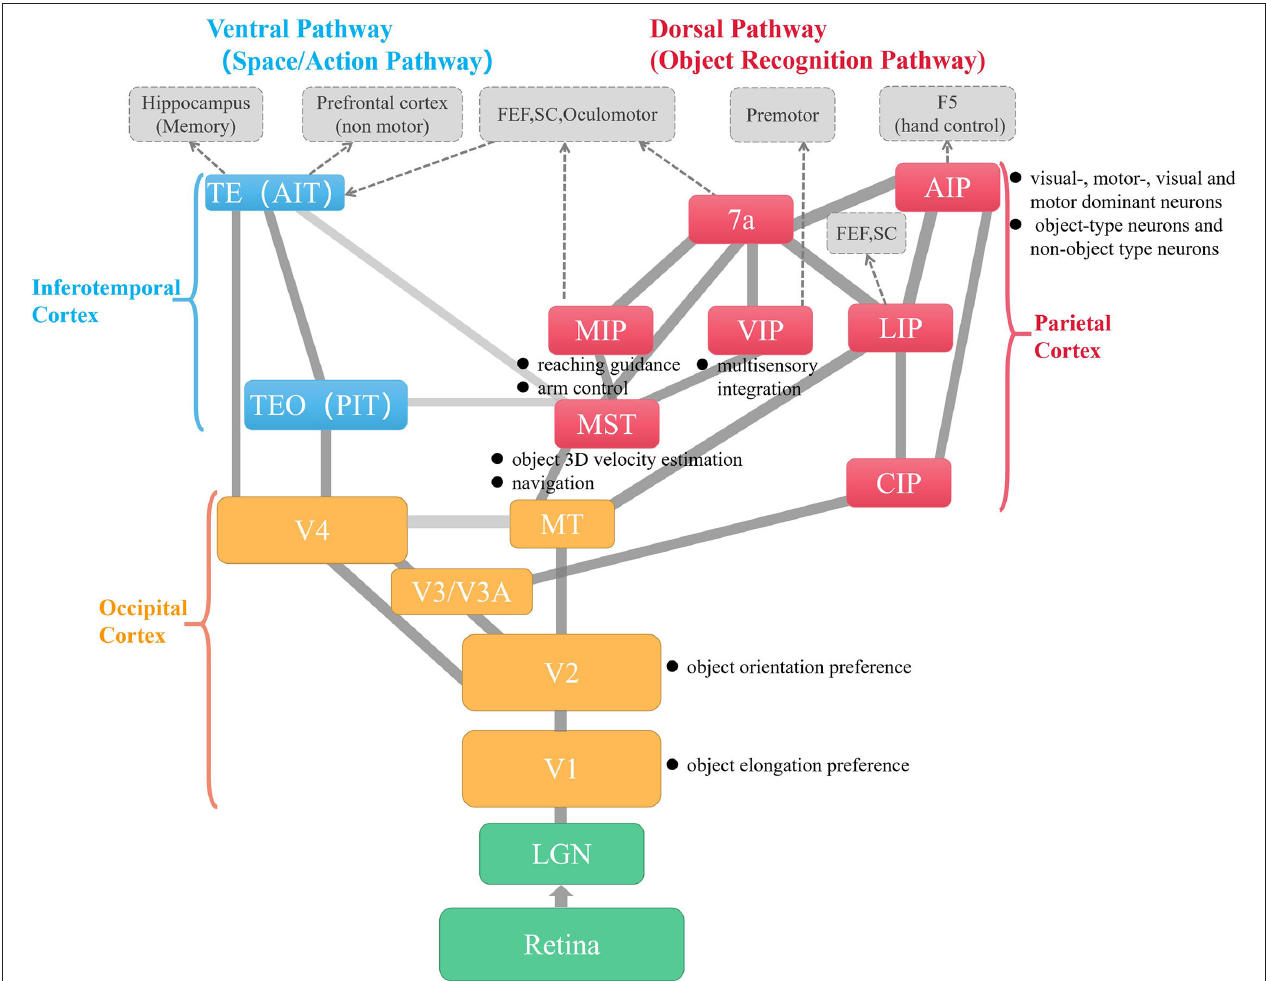
FIGURE 2 | The visual and dorsal pathways of the primate visual cortex and their connected regions. Excepting retina and LGN in green, the yellow, red, and blue blocks are areas that are in the occipital cortex, parietal cortex, and inferotemporal cortex, respectively. The gray blocks with dotted borders are areas in other cortexes related to motor perception, learning, and control. The black texts with dot marks following each block explain the area’s functions from the manipulation aspect ( Goldman-Rakic and Rakic, 1991; Prevosto et al., 2009; Kruger et al.,